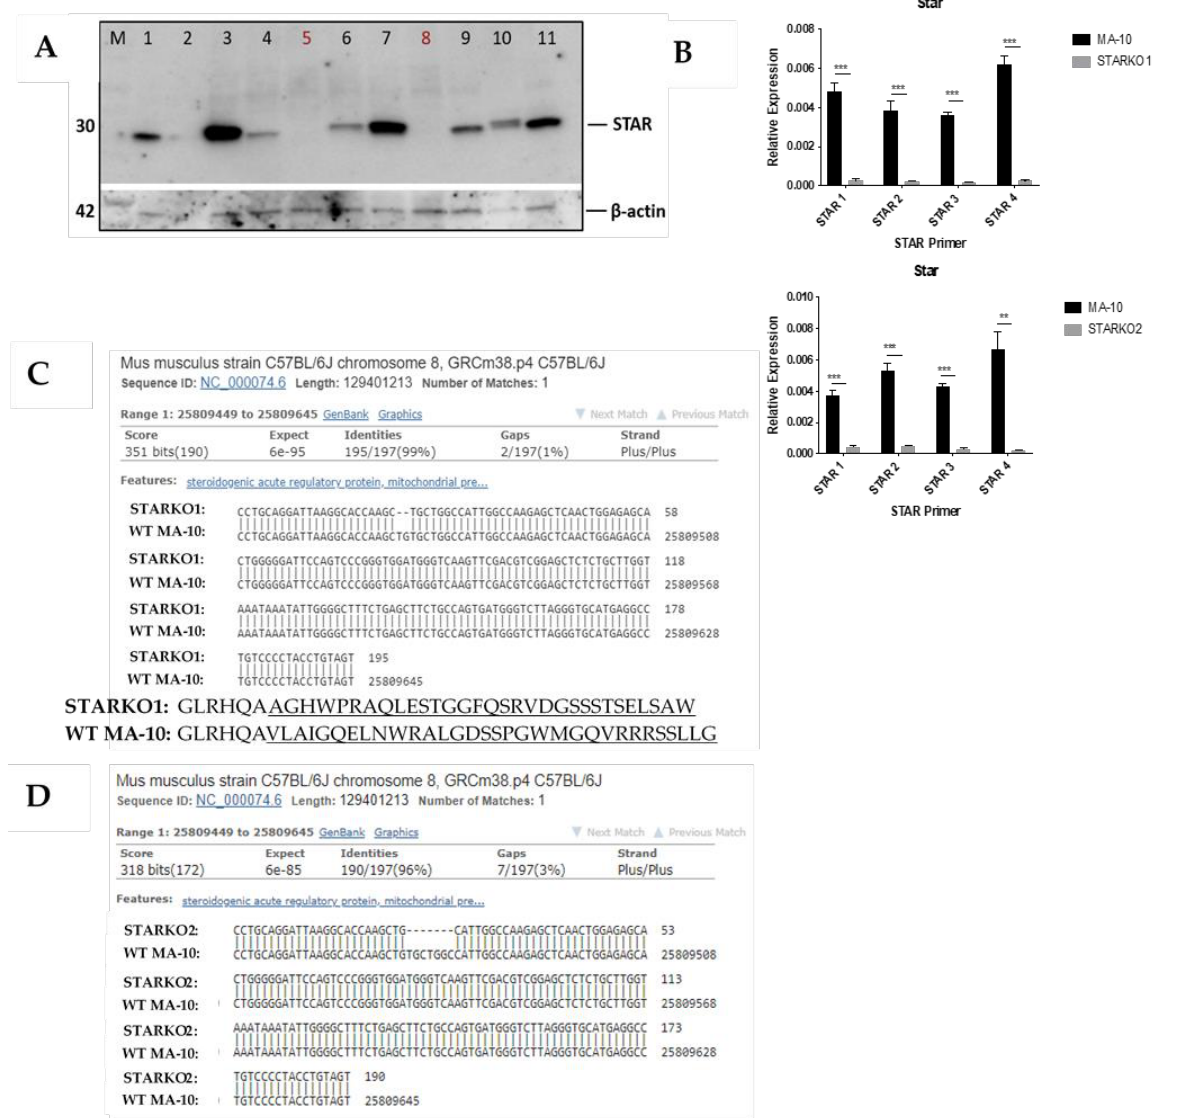
Figure 2. Screening and validation of CRISPR/Cas9-mediated STAR KO in MA-10 cells. ( A ) Western blot screening for STAR KO cell line following CRISPR/Cas9-mediated STAR KO and FACS. Samples in lane 5 (STARKO2) and lane 8 (STARKO1) show no STAR band and, therefore, are STAR KOs. ( B ) qRT-PCR analyses of STARKO1 and STARKO2 where Gapdh was used as the housekeeping gene. STAR 1, STAR 2, STAR 3, and STAR 4 are primers for various regions of the mouse Star gene. Data are shown as the mean ± SD ( n = 3). ** p < 0.01; *** p < 0.001. ( C ) BLAST DNA sequence of Star in STARKO1 cells (top) compared to wild-type mouse Star (bottom). Dashes represent nucleotide deletions. Amino acid sequence of wild-type STAR (top) compared to that of STARKO1 (bottom). Highlighted amino acids represent sequence changes. ( D ) BLAST DNA sequence of Star in STARKO2 cells (top) compared to wild-type mouse Star (bottom). Dashes represent nucleotide deletions. Amino acid sequence of wild-type STAR (top) compared to that of STARKO2 (bottom). Underlined amino acids represent sequence changes.